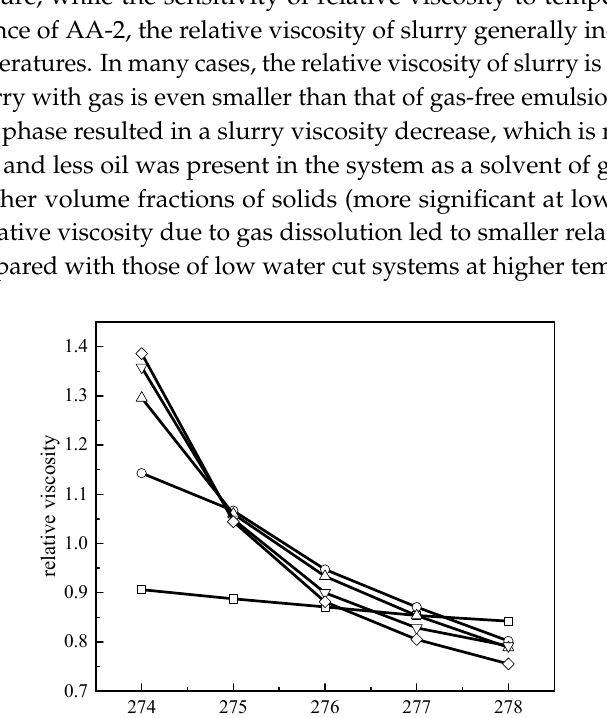
Table 2. Conversion ratios of water and volume fractions of different phases for equilibrium viscosities for annealed hydrate slurries with AA-2 formed at 278.2 K, with initial pressure of 6.0 MPa and stirring speed of 300 rpm and a water cut from 5% to 25% 1 .